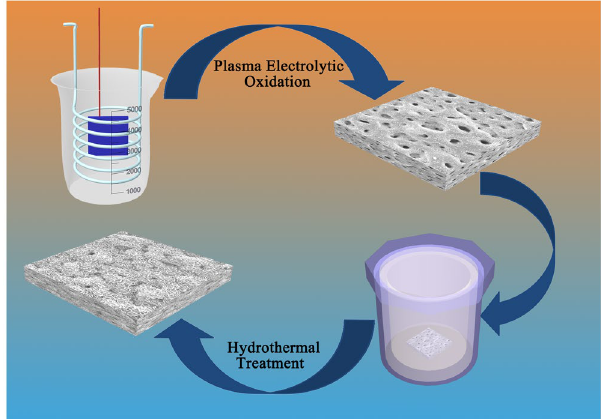
Figure 1. The process of fabricating PEO/LDH